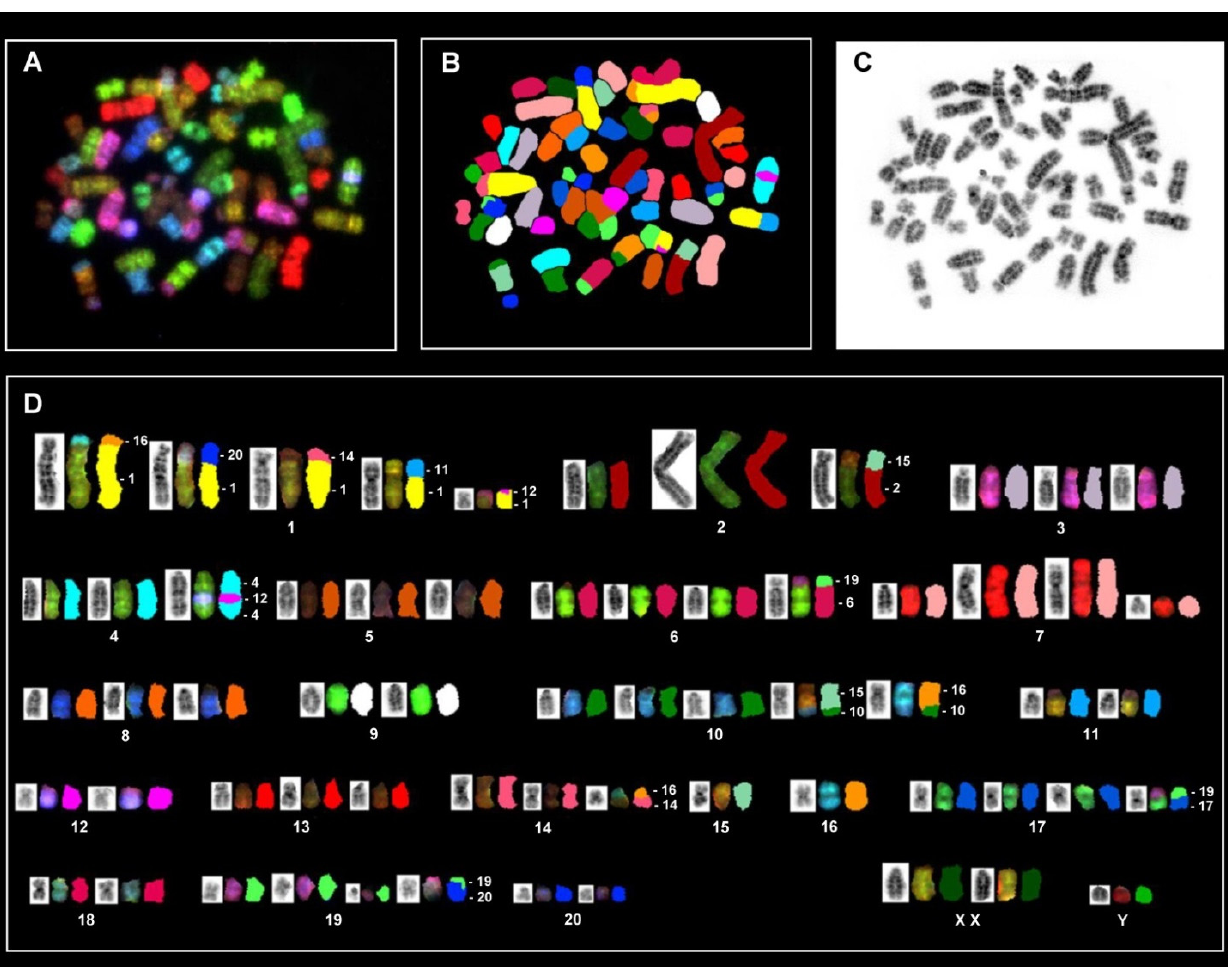
Table 3. Common and sporadic structural chromosomal aberrations ( • ) in CFSC-2G identified through spectral karyotyping.